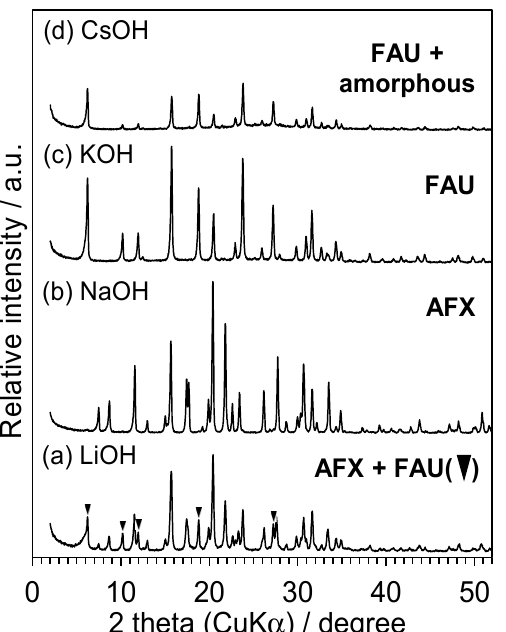
Figure 5. XRD patterns of the products crystallized with TEBOP and hydroxide of ( a ) Li, ( b ) Na, ( c ) K, and ( d ) Cs in the starting hydrogel.